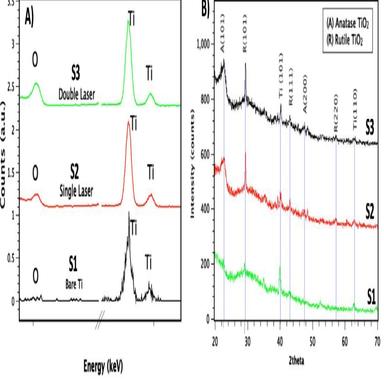
a: EDX results and b: XRD results of S1, S2 and S3.